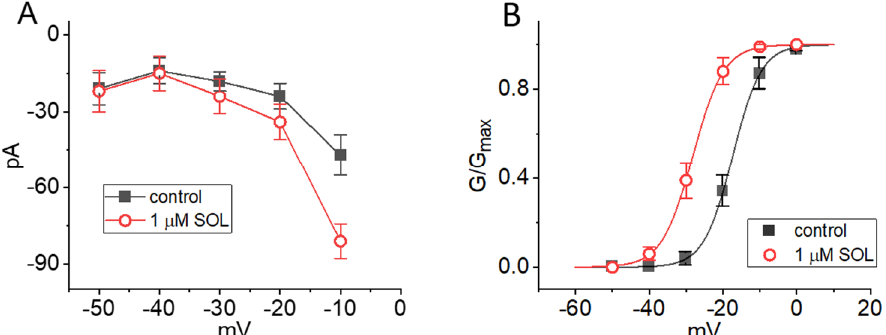
Figure 5. Effect of SOL on the current-voltage ( I-V ) relationship ( A ) and activation curve ( B ) of I K(M) identified in GH 3 cells. In these experiments, the examined cell was held at − 50 mV and the voltage pulses ranging between − 50 and 0 mV in 10-mV step were applied to it. ( A ) Averaged I-V relationship of I K(M) taken in the absence ( ■ ) and presence ( ○ ) of 1 μM SOL (mean ± SEM; n = 8 for each point). Each data point was taken at the end-point of each voltage pulse. ( B ) Activation curve (i.e., normalized conductance versus membrane voltage) of I K(M) obtained in the control period ( ■ ) and during exposure ( ○ ) to 1 μM SOL (mean ± SEM; n = 8 for each point). The smooth continuous lines give best fit to a modified Boltzmann equation as stated in Materials and Methods. Of note, a leftward shift along the voltage axis in the activation curve of I K(M) recorded from GH 3 cells is illustrated in the presence of 1 μM SOL, despite no perturbation in the apparent gating charge of the current. The statistical analyses in ( A ) and ( B ) were undertaken by ANOVA-2 for repeated measures, p (factor 1, groups among data taken at different level of membrane potentials) < 0.05, p (factor 2, groups between the absence and presence of SOL) < 0.05, p (interaction) < 0.05, followed by post-hoc Fisher’s least-significance difference test ( p < 0.05).